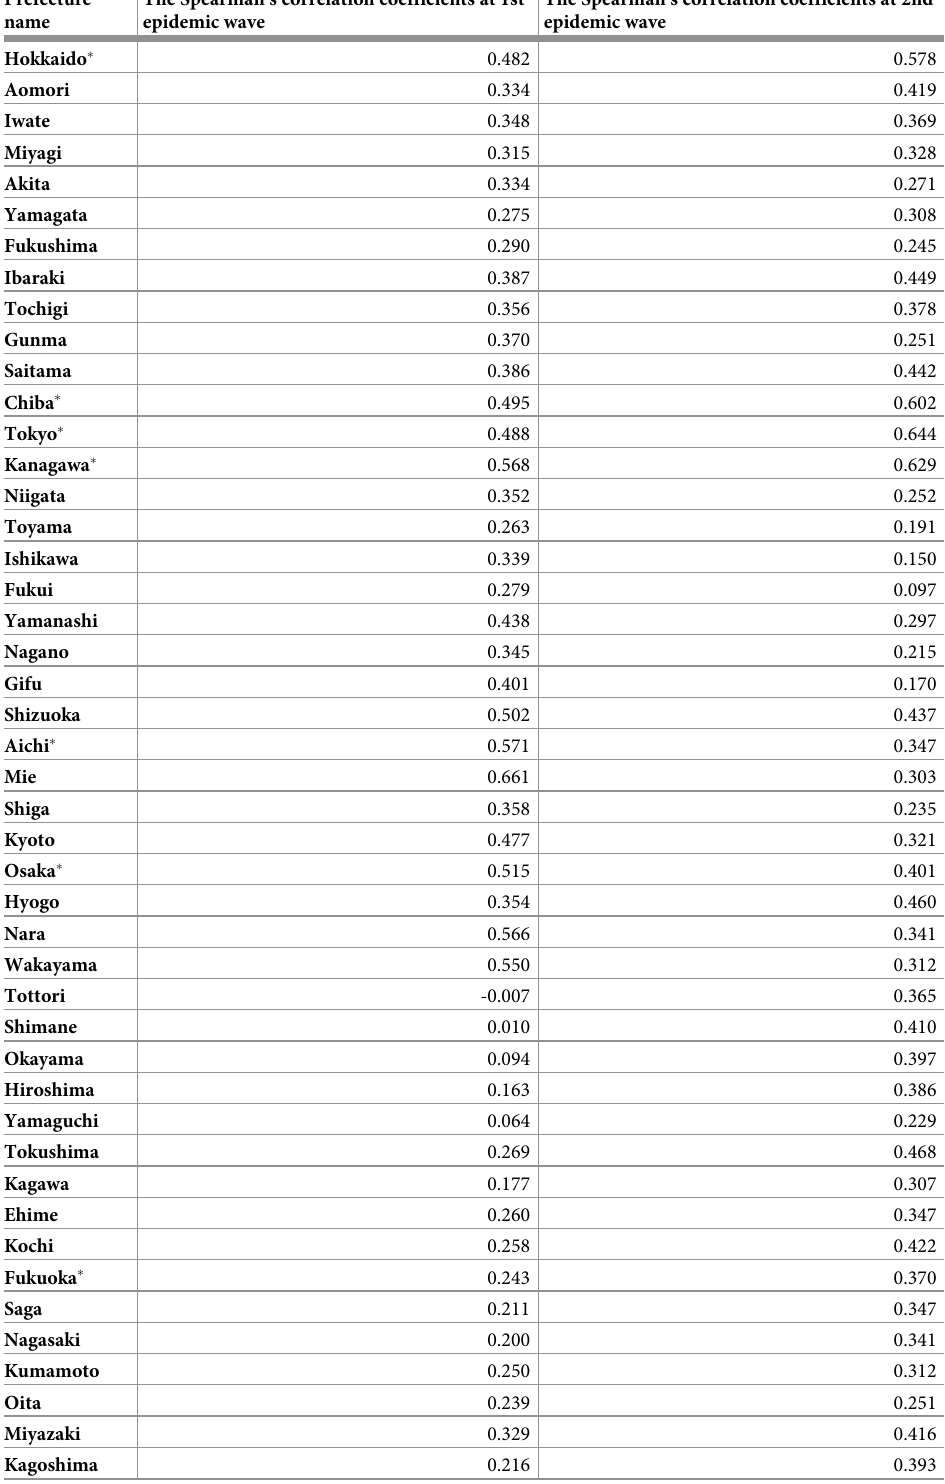
Table 1. Correlation between time of arrival and effective